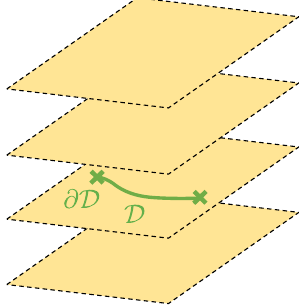
Figure 29: Layer construction of the codimension-3 point defects in (3 + 1)D topolog- ical order. The open twist string from the (2 + 1)D topological order is embedded D in the j th layer and becomes an open twist string in the (2 + 1)D topological order after condensing pair of pure charge and anti-charge in the neighboring layer. The endpoints of the open twist string, i.e., ∂ form the codimension-3 point defects in D (3 +